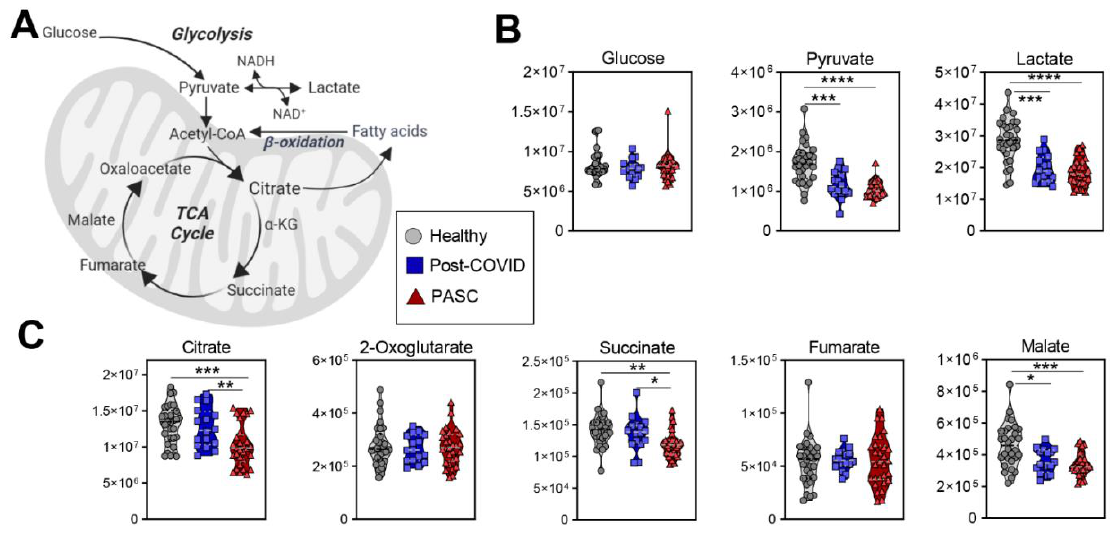
Figure 4. Glycolysis and TCA Cycle. ( A ) A pathway map for energy metabolism is shown, along with metabolite values for ( B ) glycolysis, and ( C ) the tricarboxylic acid (TCA) cycle. FDR uncorrected * p < 0.05; ** p < 0.01, *** p < 0.001, **** p < 0.0001.